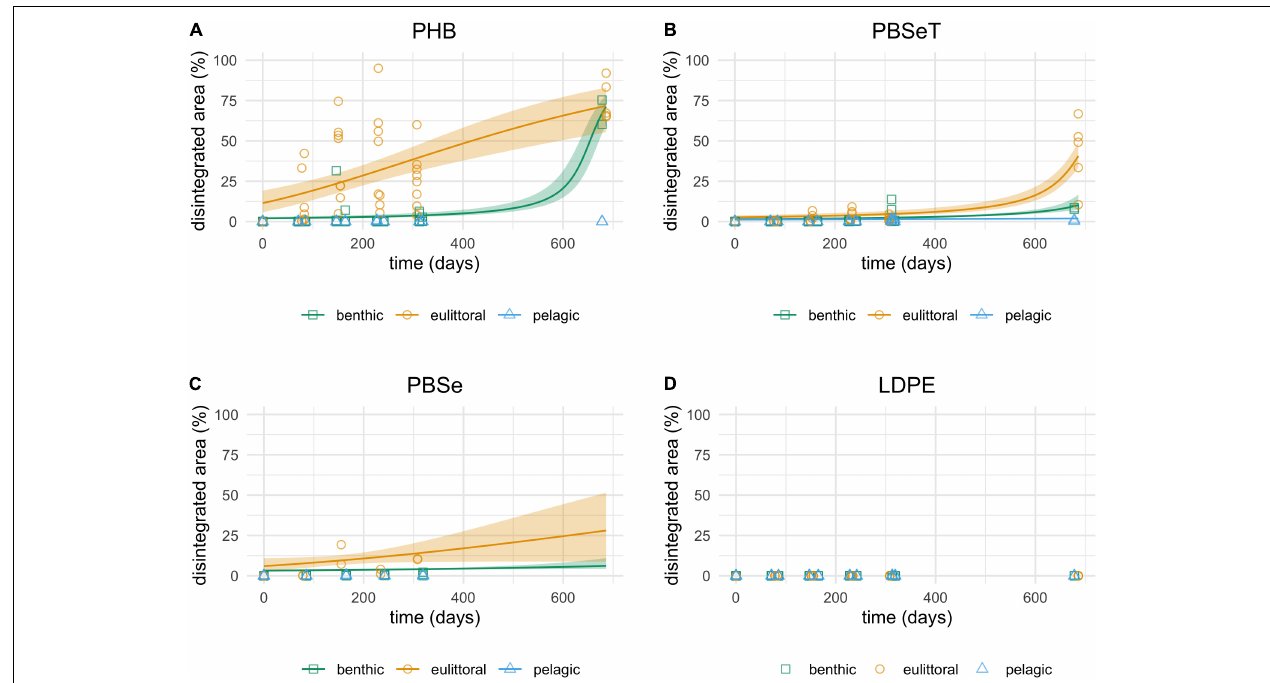
FIGURE 6 | Field experiments in the Mediterranean Sea: disintegration curves of (A) PHB, (B) PBSeT, and (C) PBSe when exposed on the seafloor at the sediment-seawater interface (benthic), the beach (eulittoral) and the water column (pelagic) scenario. (D) For LDPE no disintegration was measured. The model curve ± SE (shaded area) was drawn if the slope was different to zero and positive. Dots represent raw data analyzed in the model. Colors represent the habitat (green = benthic, orange = eulittoral, blue =